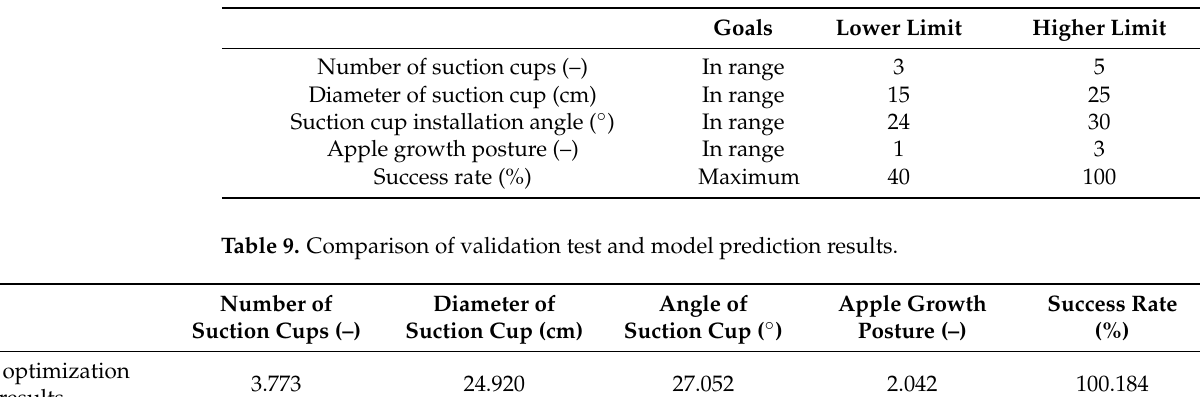
Table 8. Optimization conditions.